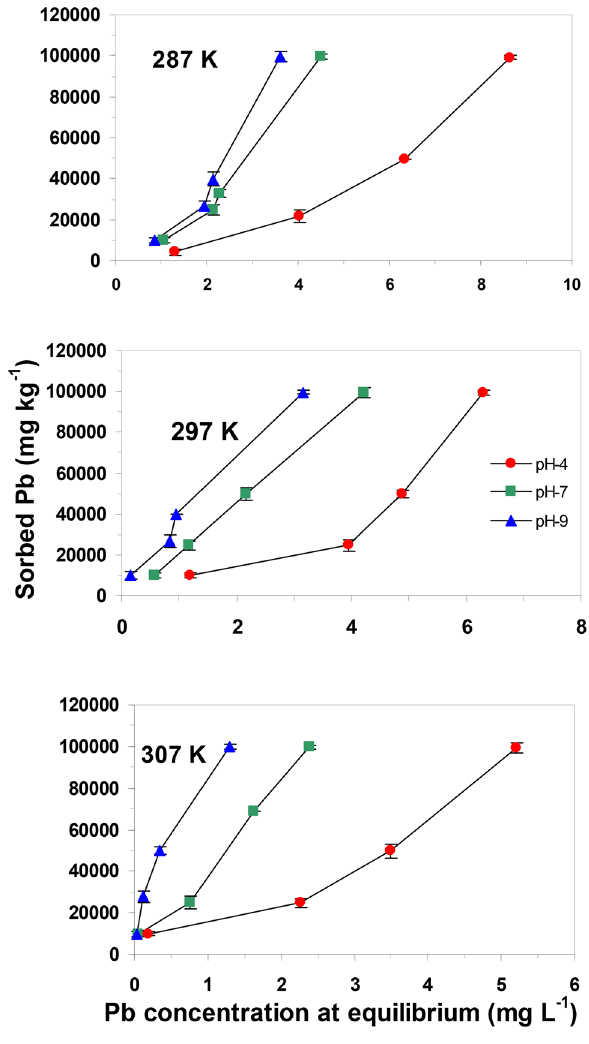
Figure 6. Effect of pH on Pb(II) adsorption by nanocomposite (nMgO-bentonite) at different temperatures (287, 297, and 307